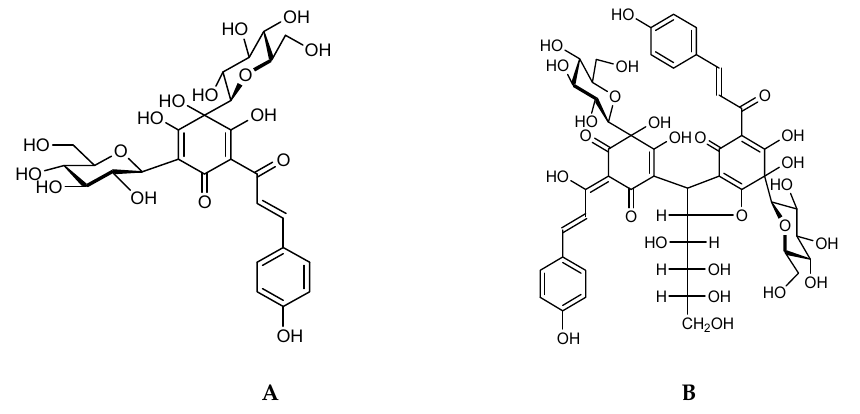
Figure 1. Chemical structures of HSYA ( A ) and ASYB ( B ).